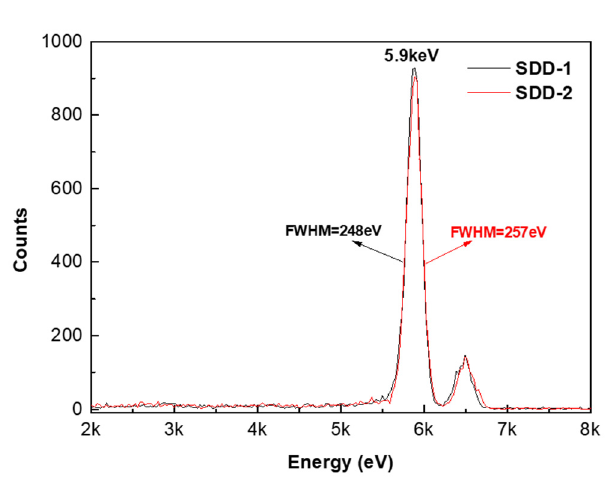
Figure 10. Energy spectrum of Fe-55 measured by SDD-1 and SDD-2, respectively.